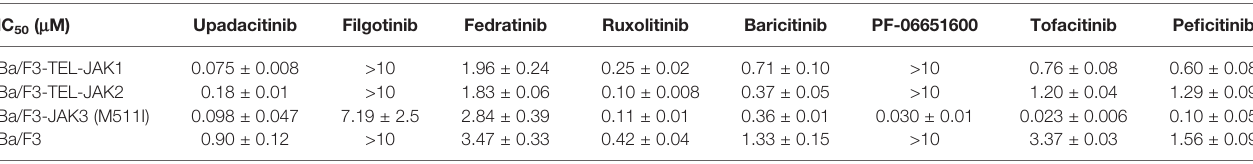
TABLE 2 | JAK3 inhibitors selectively suppress the proliferation of Ba/F3-JAK3-M511I cells. IC 50 ( m